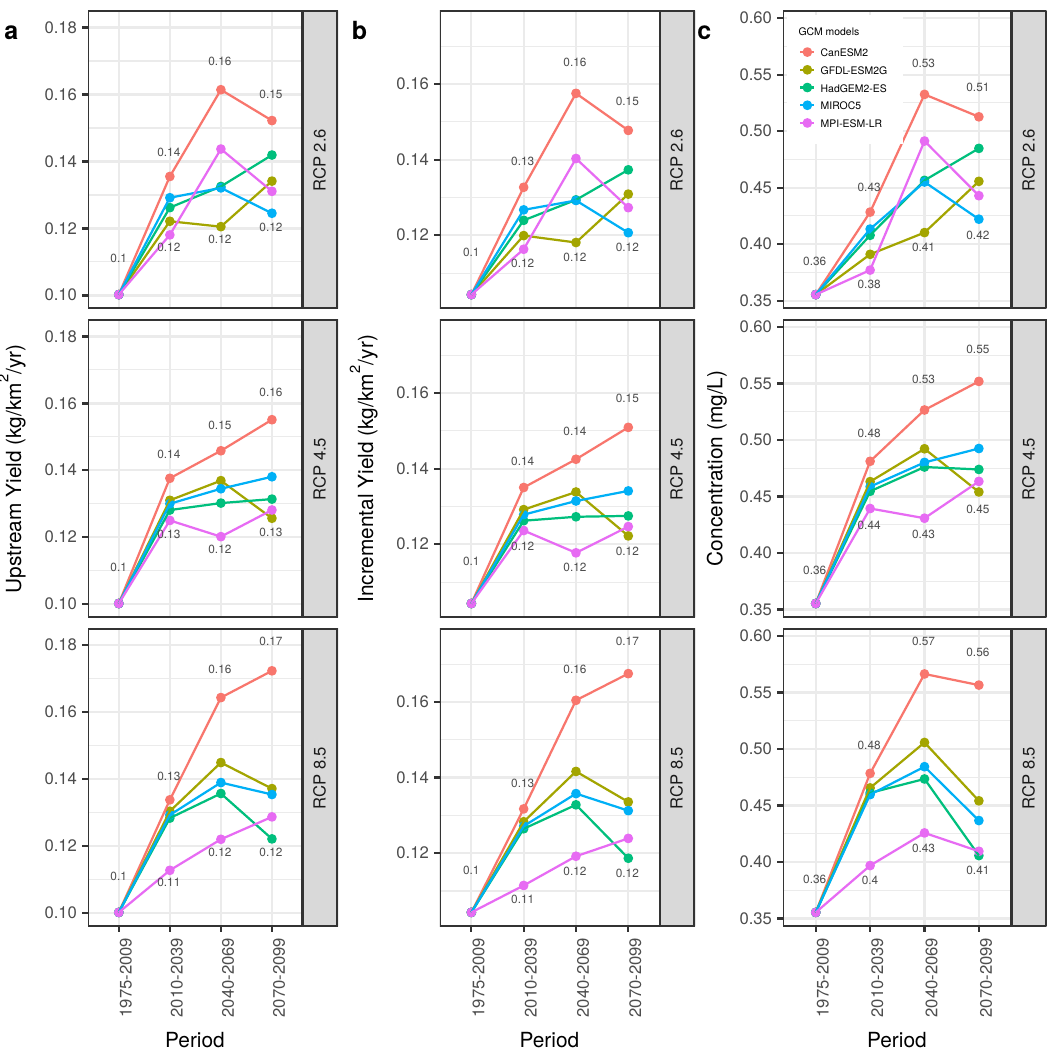
Figure 4. Projections of spatio-temporal annual averages of ( a ) upstream yield (kg km − 2 year − 1 ); ( b ) incremental yield (kg km − 2 year − 1 ) and ( c ) concentration (mg L − 1 ) for TP. Minimum and